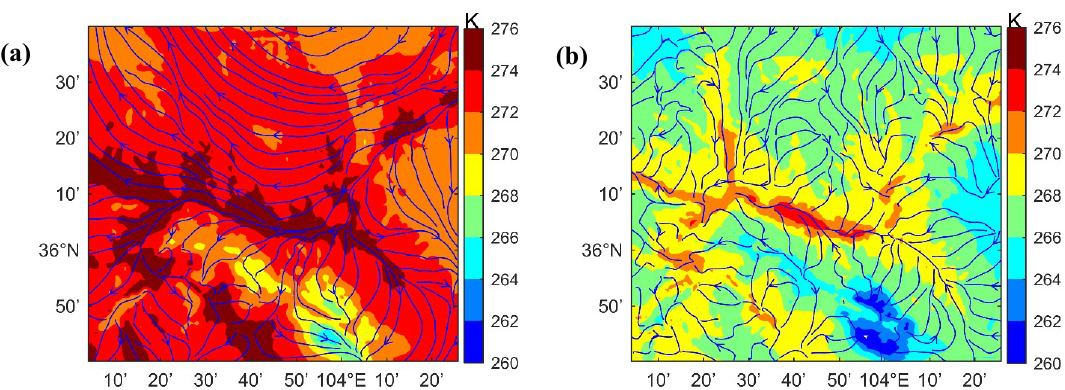
Figure 2. Average 2-m temperature (shading) and 10-m wind flow field (blue line) at ( a ) 14:00 Beijing Time (BT) and ( b ) 20:00 BT over Lanzhou during six winters from 2002 to 2007.